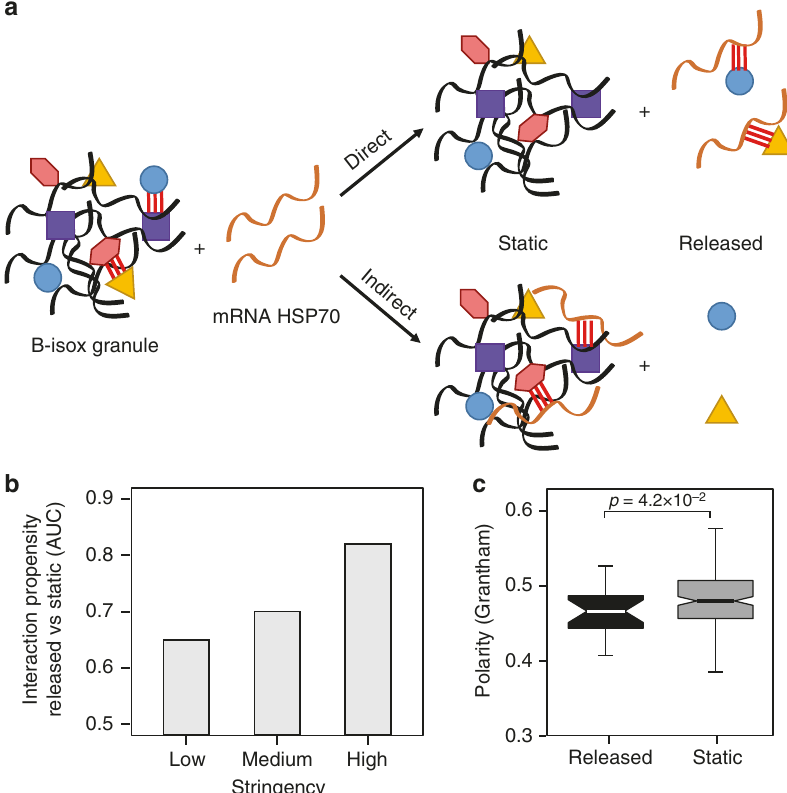
Fig. 5 Interactions within the ribonucleoprotein condensate. a The release of proteins from the biotinylated isoxazole (b-isox) assembly could be the outcome of: (1) an indirect process, resulting from an interaction competition between RNA and the protein aggregate or (2) a direct process, resulting from protein sequestration by RNA. b catRAPID performances improve with the stringency of the b-isox experiments (Methods), suggesting a direct recruitment of proteins rescued by high structured (HS) RNA. The false discovery rate (FDR) becomes highly signi fi cant for the most-stringent experimental set (FDR = 0.1). c ‘ Released ’ proteins (black box) are less polar than ‘ static ’ ones (grey box), in agreement with our computational analysis ( p value = 4.7 × 10 – 2 , p value estimated with KS test; see also Fig. 2f, g). Released and static proteins correspond to the black and grey dots of Fig. 4b right panel. The boxes show the interquartile range (IQR), the central line represents the median, the notches the 95% con fi dence interval of the median, the whiskers add 1.5 times the IQR to the 75 percentile (box upper limit) and subtract 1.5 times the IQR from the 25 percentile (box lower limit). S.d. is functional roles and, in turn, evolutionary selection 12 . Thus, our fi ndings are reminiscent of the ‘ target accessibility ’ model that links protein – RNA recognition to the secondary structure of physical contacts 61,62 .